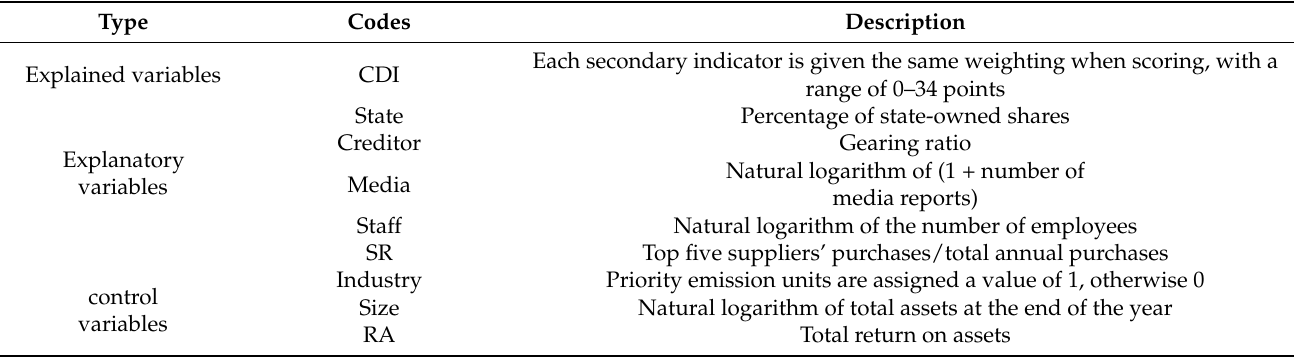
Table 2. Full variable design.